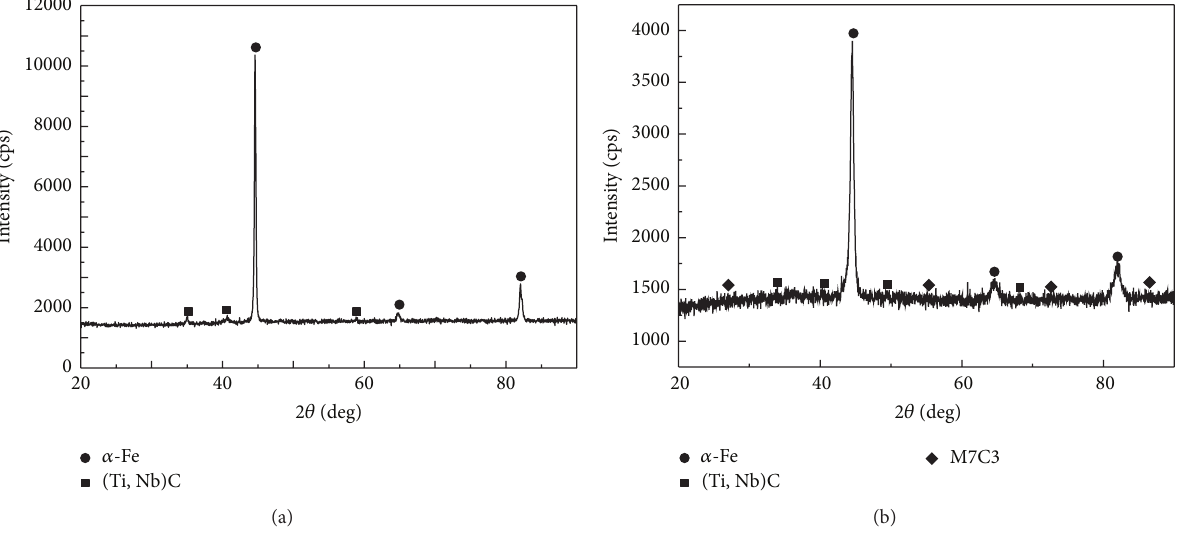
Figure 5: XRD results: (a) alloy 2 and (b) alloy 8.